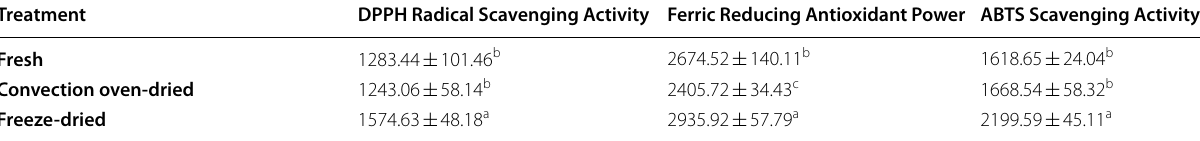
Values are expressed as mean standard deviation ( n 5). Means with different superscripts (a-c) within a column, indicate significant differences ( p <0.05) based on ± = ANOVA and Tukey’s HSD test. Values are expressed as mg Trolox equivalent/100 g DW